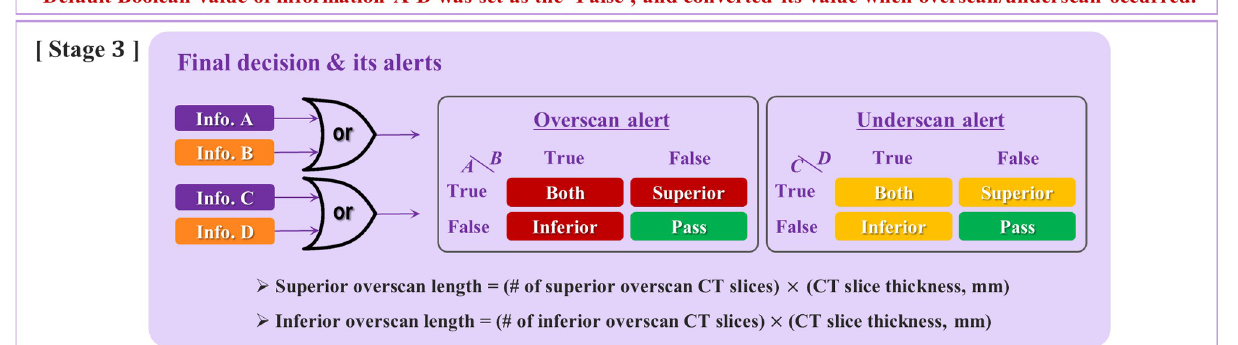
Fig 2. Schematic diagram of overscan determination process. Stage 1: AI-assisted landmark segmentation. Stage 2: Rule-based logical operations. Stage 3: Final overscan decision and its alerts.